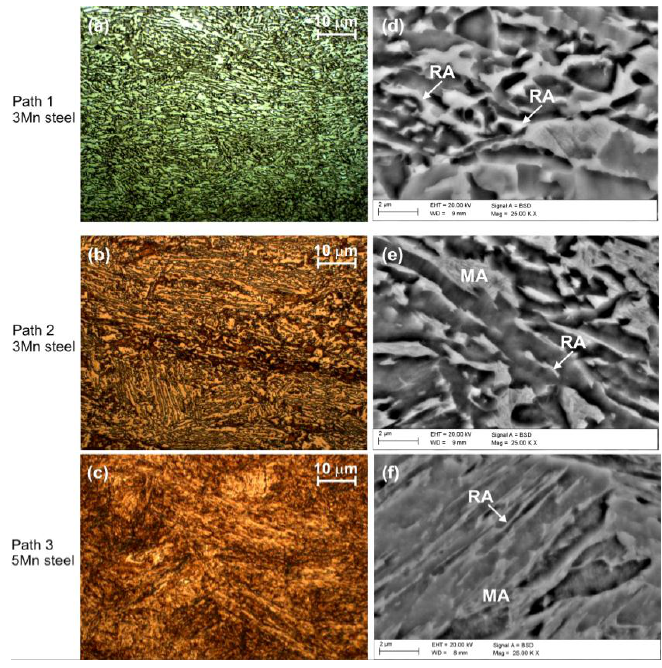
Figure 12. Multiphase bainite-based microstructures obtained after the thermomechanical treatment in the Gleeble simulator: ( a – c ) light microscopy (LM); ( d – f ) scanning electron microscopy (SEM); RA—retained austenite, MA—martensite-austenite